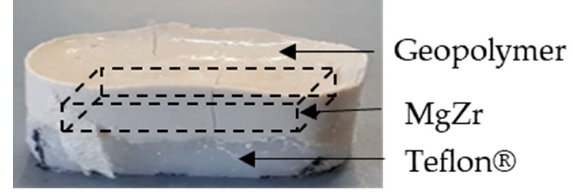
Figure 1. Description of a